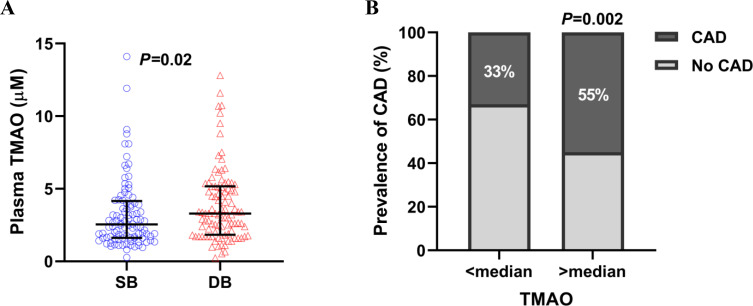
Association between gut microbiome composition, TMAO levels, and CAD.(A) TMAO levels were higher in patients with dysbiosis (N = 100) than those without (N = 100) (Mann-Whitney U test P = 0.02). (B) CAD was more prevalent in patients with >median levels of TMAO than those with <median levels of TMAO (55/100 (55%) vs. 33/100 (33%), χ2 test P = 0.002). CAD, coronary artery disease; DB, dysbiosis; TMAO, trimethylamine N-oxide.